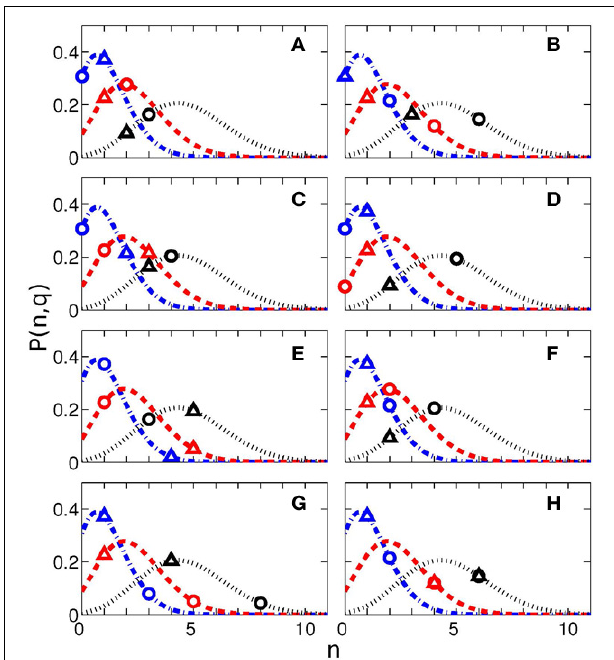
FIGURE 5 | Probability to have n cases with probability q within N measurements (see Equation 1) for different interval durations: 0.5s (A), 2s (B), 3s (C), 7s (D), 10s (E), 14s (F), 25s (G), and 40s (H). The blue dash-doted, red dashed, and black dotted lines correspond to the probability q = 0 . 05, q = 0 . 1, and q = 0 . 2. The experimentally obtained values of N q (see Table 3 ) and corresponding probabilities are shown by triangles (for reproduction begin) and circles (for reproduction end). The total number of measurements for each time interval is N = 23.